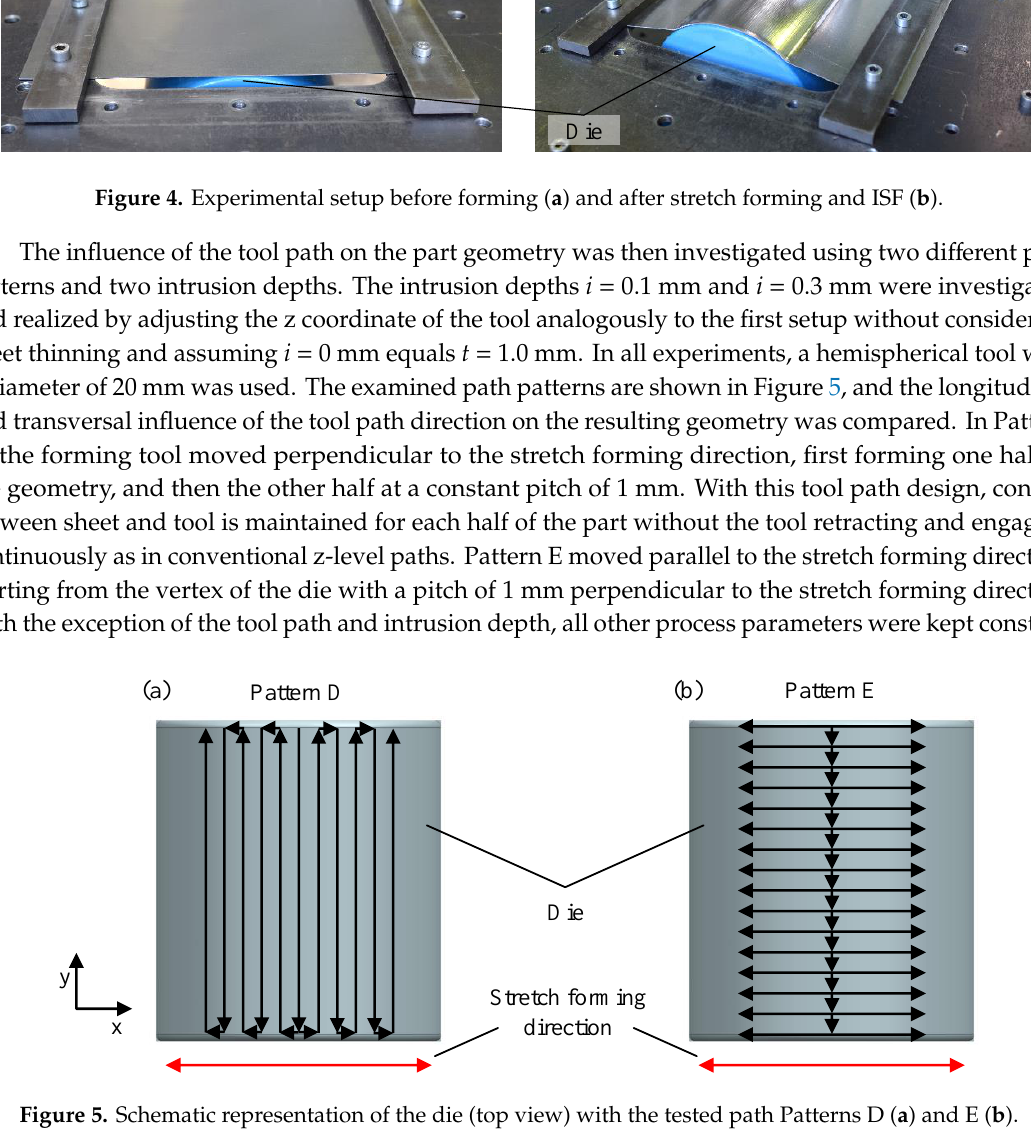
Figure 5. Schematic representation of the die (top view) with the tested path Patterns D ( a ) and E ( b ).